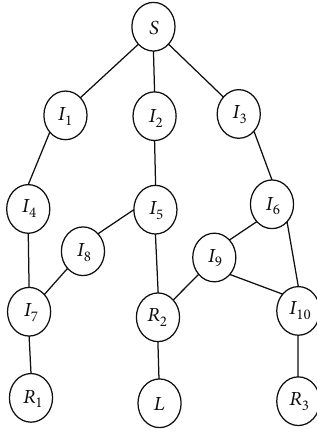
Figure 1: An example network